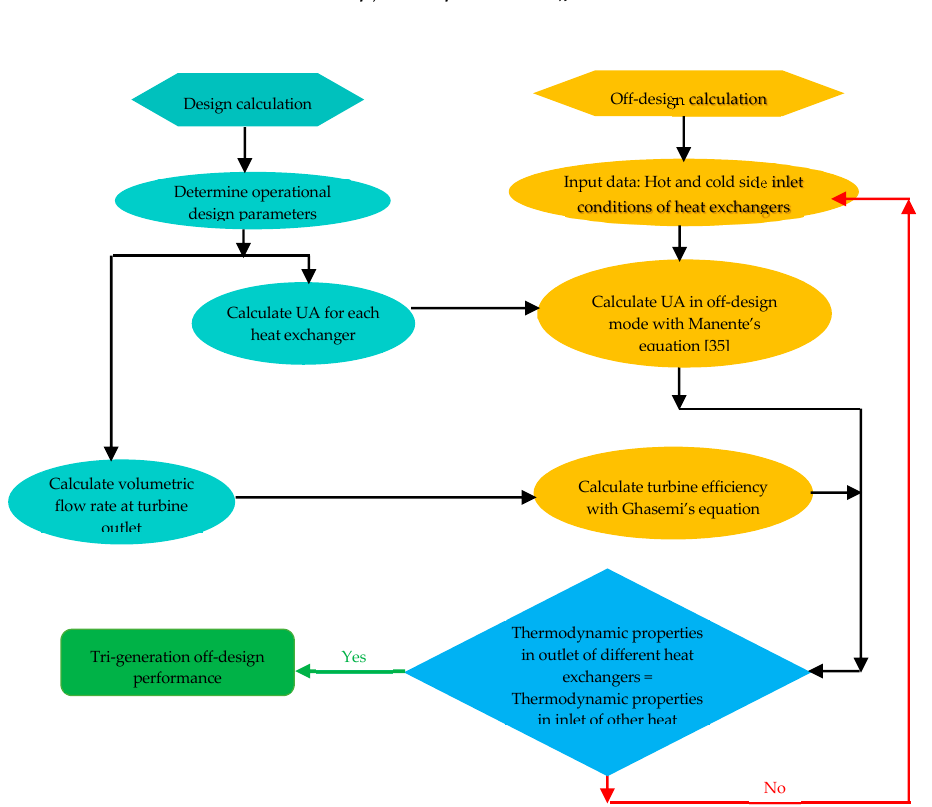
Figure 2. O ff -design calculation Figure 2. Off-design calculation procedure.